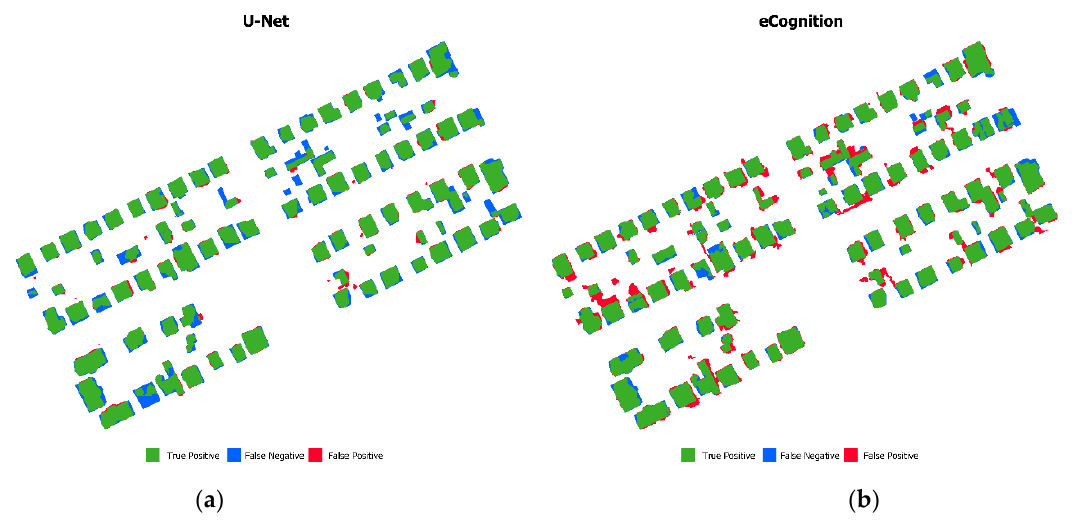
Figure 14. Example of object identification in Subotica: ( a ) U-Net; ( b ) eCognition. In the next figure (Figure 15) RGB view of the satellite image, ground truth data, prediction results and the difference between this data and ground truth data are presented. This is an example of how the resulting changes can be identified.